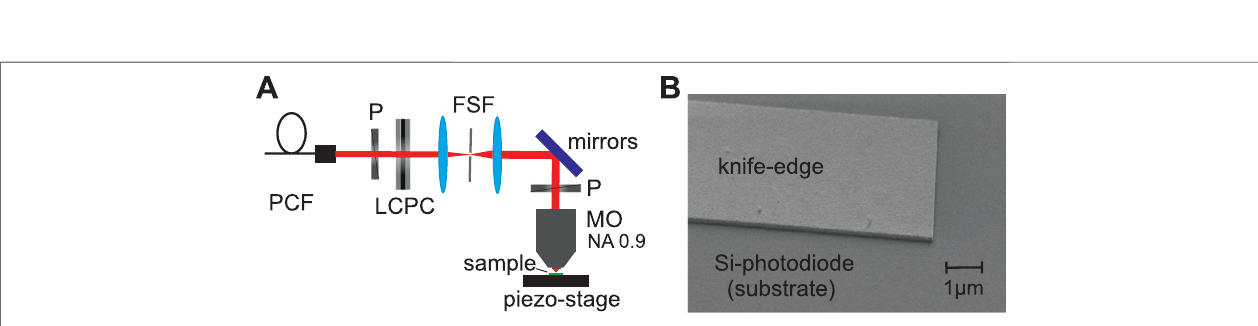
FIGURE5| Schematic illustration ofthe experimental setup (A) (P, Polarizer; LCPC, liquid crystal polarization converter;FSF, Fourierspatial fi lter; MO, microscope objective), SEM image of the used knife-edge sample (B) (gold with a thickness h (cid:1) 70 nm and a width d 0 ≈ 3 μ m fabricated on a silicon photodiode).